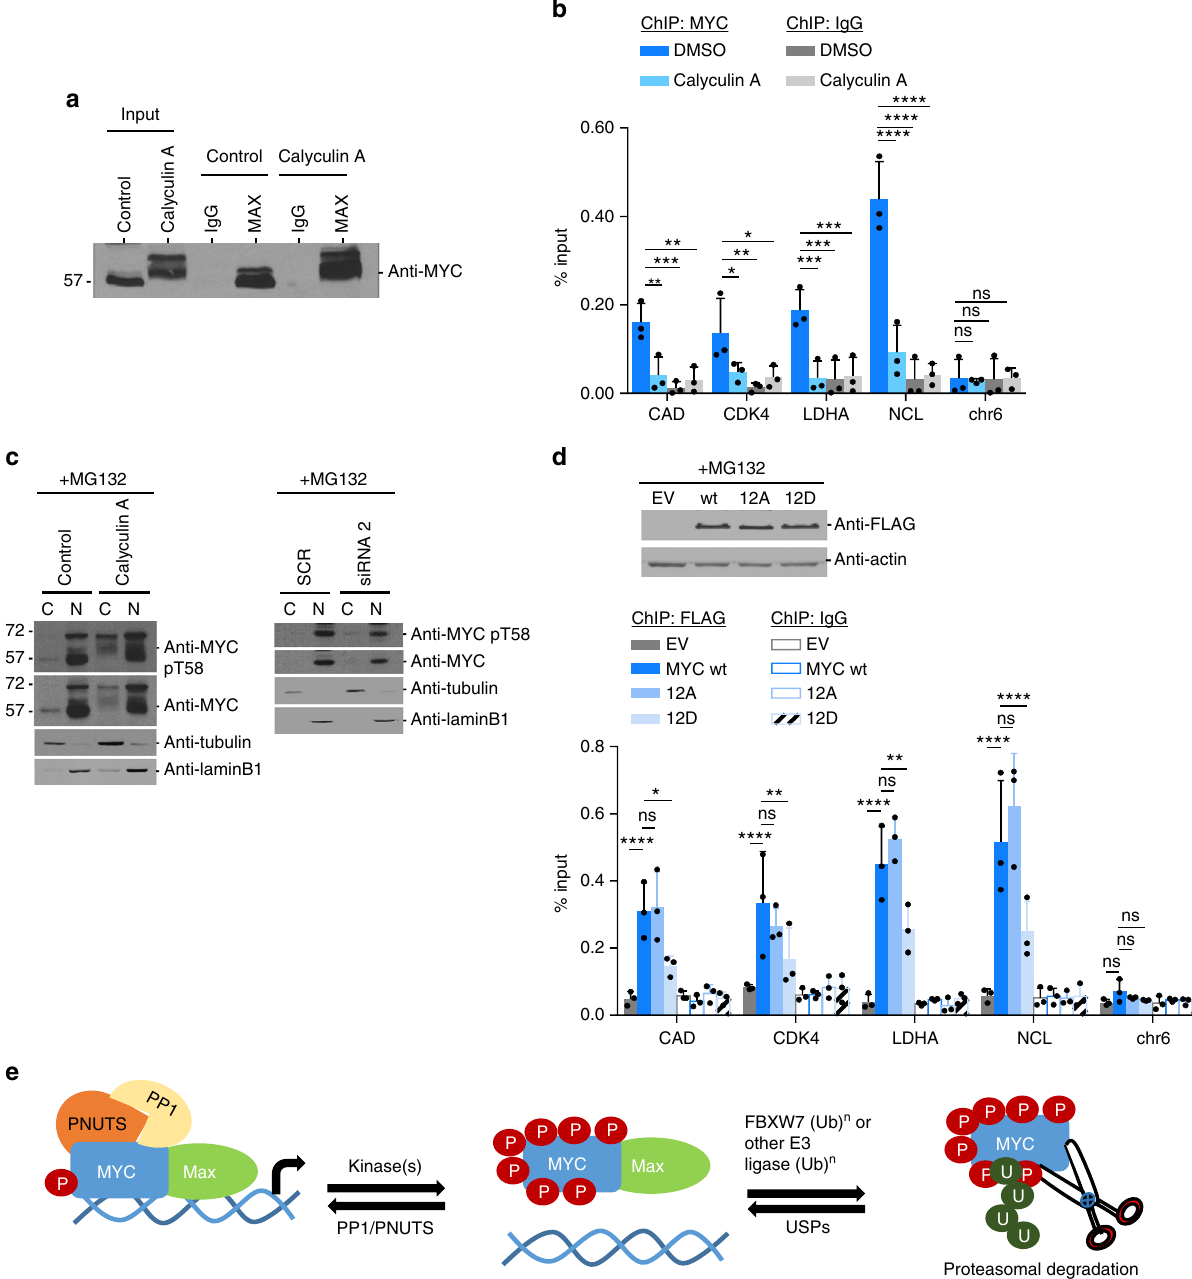
Fig. 6 Hyperphosphorylated MYC retains interaction with MAX but is compromised for chromatin binding. a MCF10A cells were treated with Calyculin A (50 nM) or vehicle control for 30 min, lysed, and immunoprecipitated with MAX rabbit or IgG rabbit antibody. The input and IP was resolved by SDS-PAGE and immunoblotted with MYC mouse antibody. Shown is a representative image of n = 3. b For ChIP analysis, MCF10A cells were treated with MG132 (10 µ M) for 4 h ± Calyculin A (50 nM) for 30 min, and lysate incubated with MYC rabbit antibody along with IgG antibody as a control. ChIP ’ d DNA was quanti fi ed by qPCR for MYC target genes promoters of CAD, CDK4, LDHA , and NCL , and chr6 (negative control). c For nuclear and cytoplasmic fractionation, MCF10A cells were treated with MG132 (10 µ M) for 4 h ± Calyculin A (50 nM) for 30 min (left panel), or transfected with 10 nM siRNA directed against PP1 α , β , and γ or universal scramble negative control by calcium phosphate for 44 h and then treated with MG132 (10 µ M) for 4 h (right panel). Lysates were used for fractionation, and immunoblotted with indicated antibodies. d MCF10A cells carrying inducible FLAG-tagged EV, MYC wt, MYC12A, or MYC12D were treated with 4-OHT (24 h) to induce expression, treated with MG132 (10 µ M) for 4 h, and then lysed for immunoblot analysis (top) or for ChIP-qPCR with FLAG or IgG antibody (bottom) as outlined in b above. For b , d : shown are % input mean (MYC and FLAG ChIP: n = 3). * p < 0.05, ** p < 0.01, *** p < 0.001, **** p < 0.0001, two-way ANOVA with Bonferroni test. Not statistically signi fi cant = ns. Error bars represent s.d. e Proposed model of PP1/PNUTS regulation of MYC hyperphosphorylation in the control of chromatin binding and